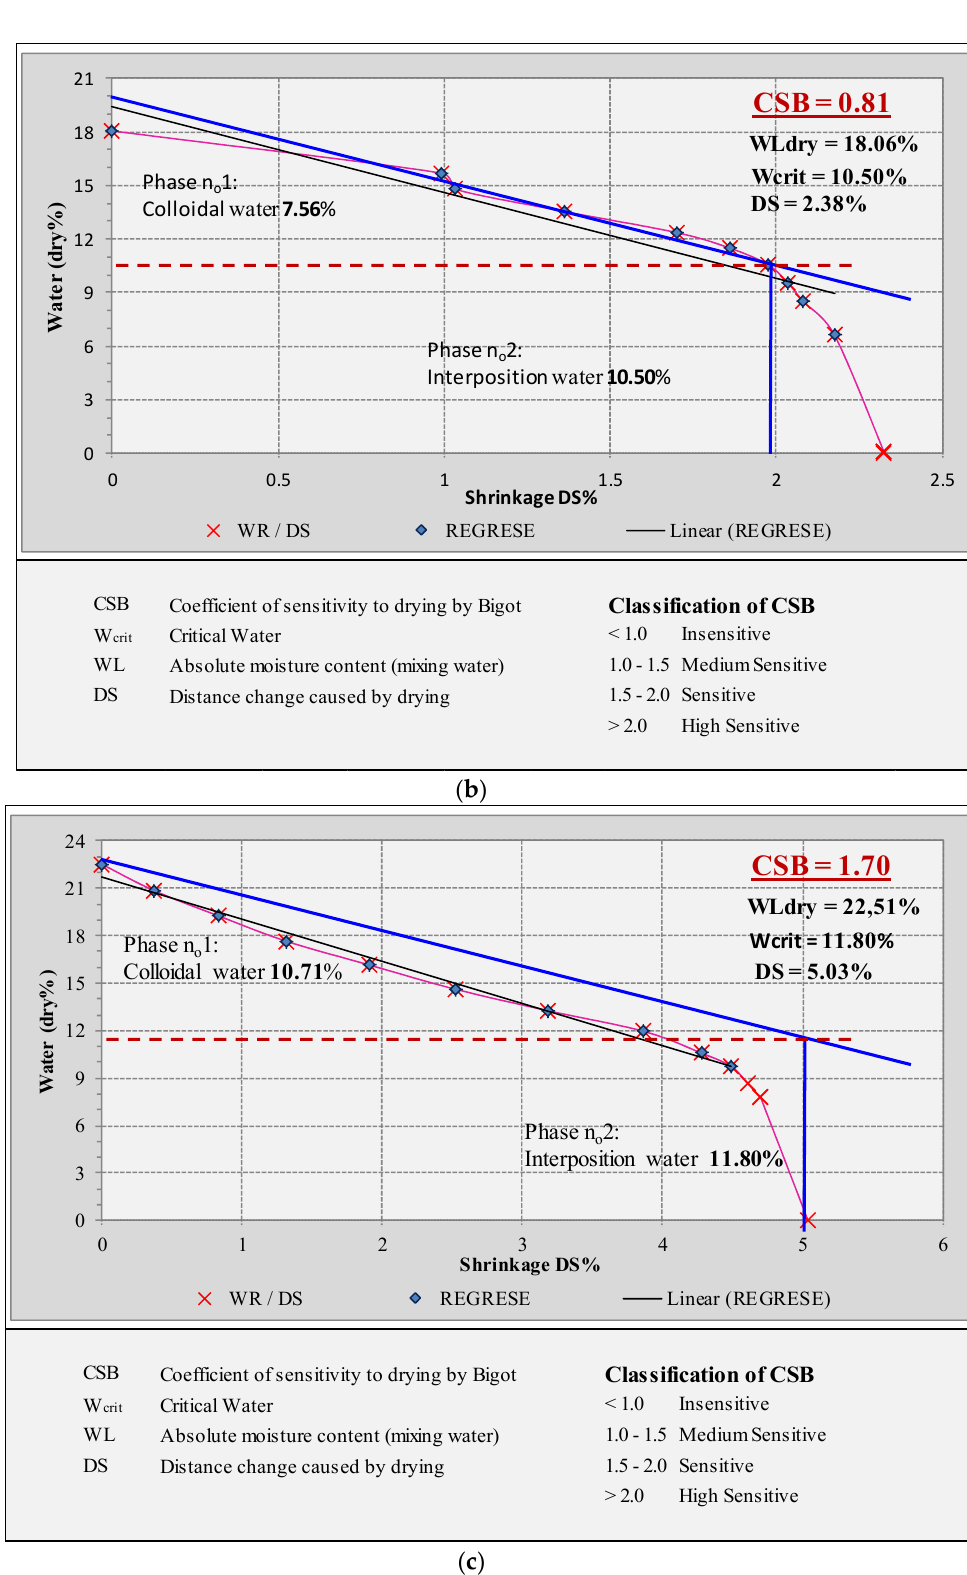
Figure A4. Detailed Bigot’s curves of ( a ) DM, ( b ) HM, and ( c ) SM.